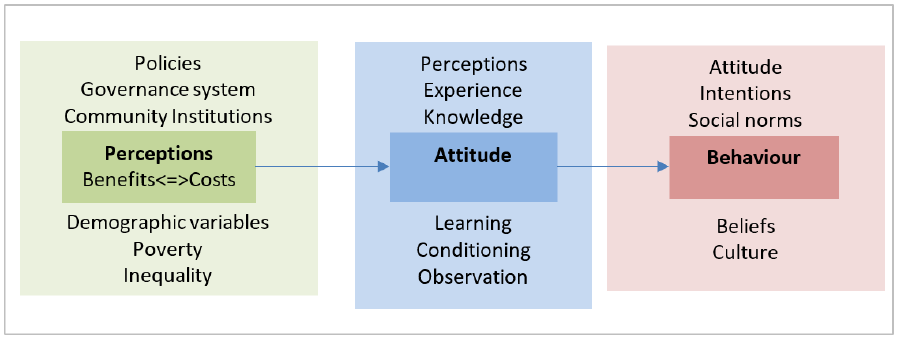
Figure 1. The link between perceptions, attitudes, and behaviour. Source: Adapted from Ntuli and Muchapondwa (2021).